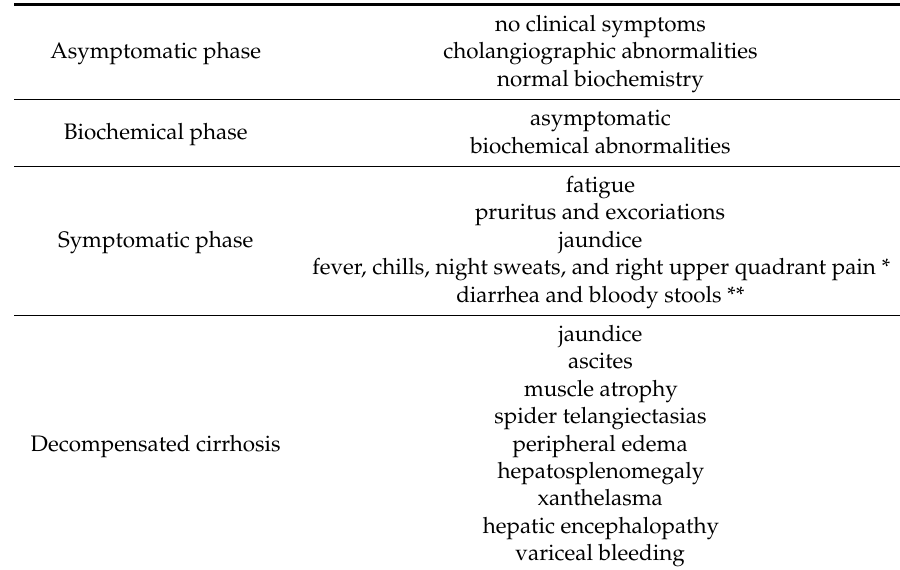
Table 1. Natural history and clinical features in